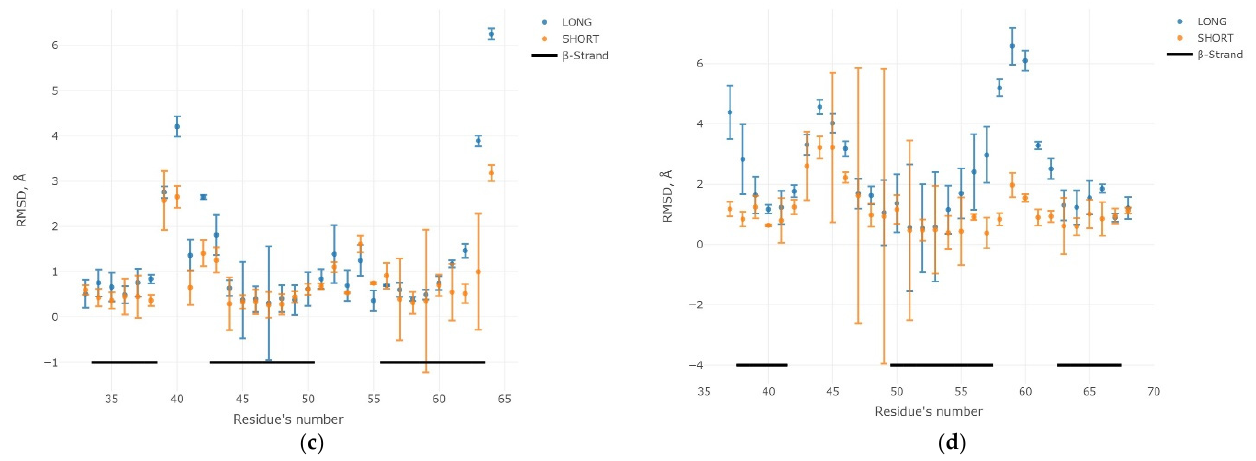
Figure 3. Comparison of changes in the values of the RMSD along the “long” (red color) and “short” (blue color) MDs. Unstructured sections of polypeptide chain are marked with omissions, whereas β -strands correspond to black lines at the bottom of each panel. Averages value of RMSD and associated standard deviations. Typical cases are presented for structures of the 3 β -corner type: 1OMV: region A605–A634 ( a ), 2CX8: region A33–A60 ( b ), 1V6Z: region A33–A64 ( c ), and 2BJQ region: A32–A62 ( d ). All changes were made in three technical repetitions.